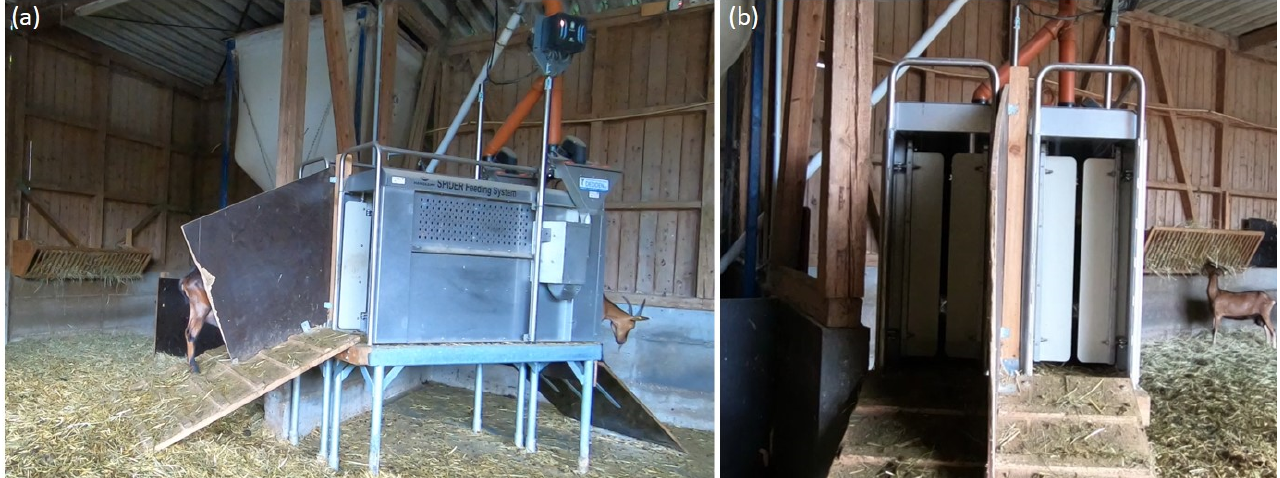
Figure 2. Photographs of the new optimized automatic feeding system. ( a ) The station in side view. ( b ) The divided entrance with the ramp.